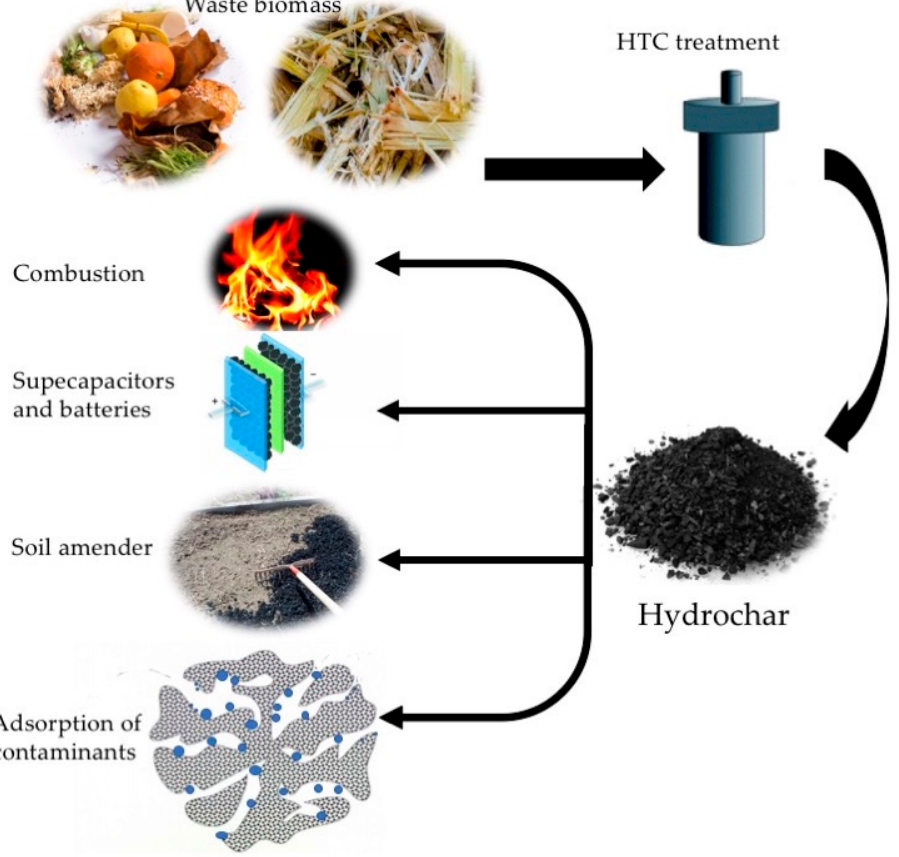
Figure 1. Waste biomass hydrochar potential applications.